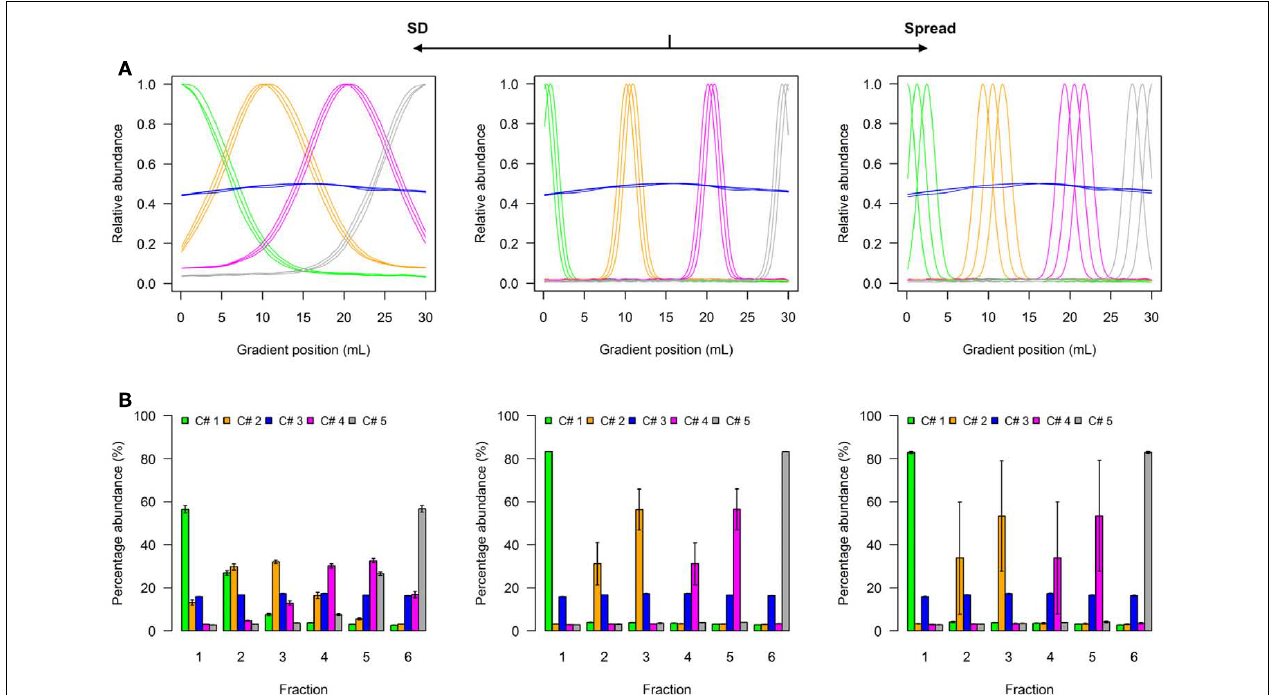
compartment-specific markers for each compartment after the continuous distributions were discretized into 6 equally spaced fractions.The left–side graph illustrates the effect of increasing the SD (SD = 5, ms = 0.4), while the right-side graph shows the effect of increasing the marker spread ms (SD = 1, ms = 1.2) compared to a standard (middle graph with SD = 1, ms =